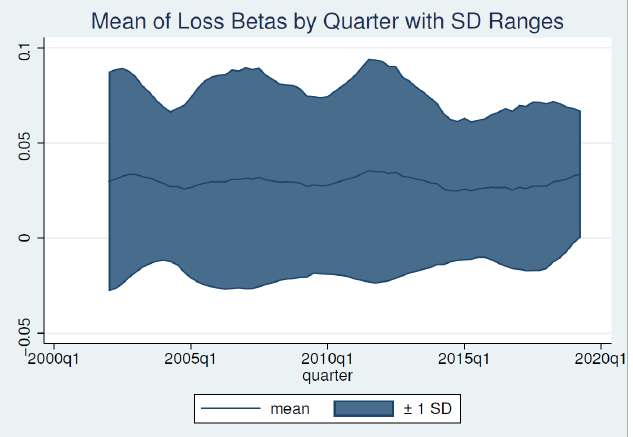
Figure A1. Histogram of Loss Portfolio. This graph displays the histogram bank’s loss portfolios by quarter. Loss portfolios are constructed following the model in Section 2 using Call Reports. The sample contains 2821 quarterly observations from the first quarter of 2002 to the second quarter of 2019 with 67 unique commercial U.S.banks with assets over $50 billions.